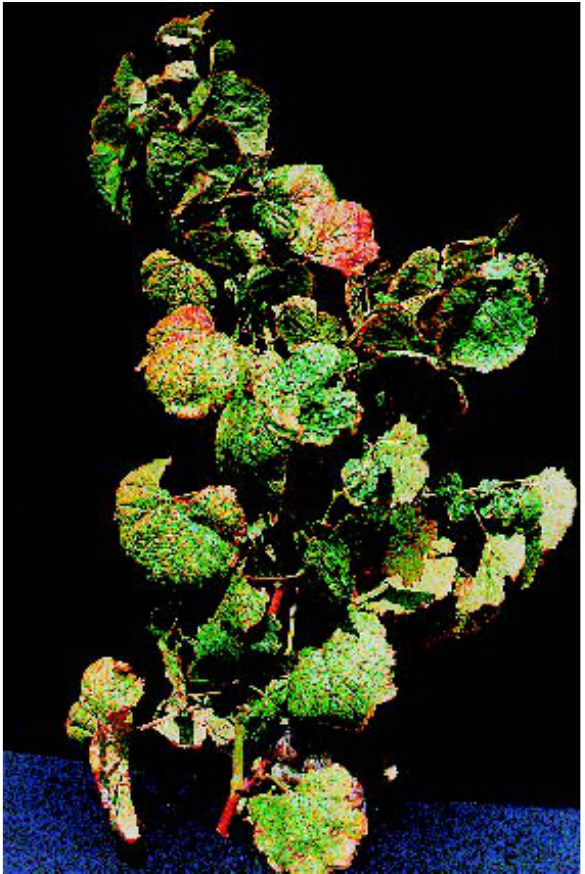
Fig. 1. Shoot and leaves of a grapevine plant of cv. Chenín showing typical symptoms of “hoja de malvón” disease.